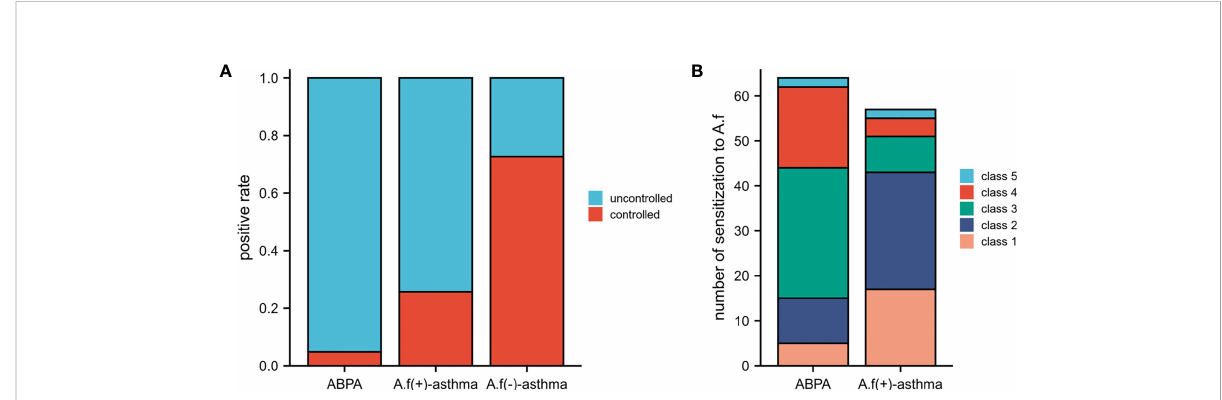
FIGURE 2 Control situation and class of A.f -sIgE in different groups. (A) Control situation among ABPA, A.f (+) asthma, and A.f ( − ) asthma. (B) Class of A.f - sIgE between ABPA and A.f (+) asthma. ABPA, allergic bronchopulmonary aspergillosis; A.f (+) asthma, Aspergillus fumigatus -sensitized asthma; A.f ( − ) asthma, non- Aspergillus fumigatus -sensitized